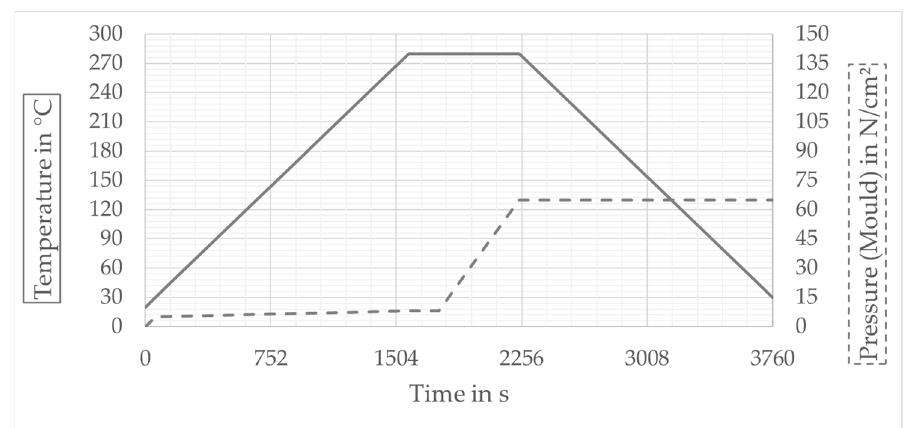
Figure 9. Sample consolidation: laboratory platen-press COLLIN 300 PV and plate tool.